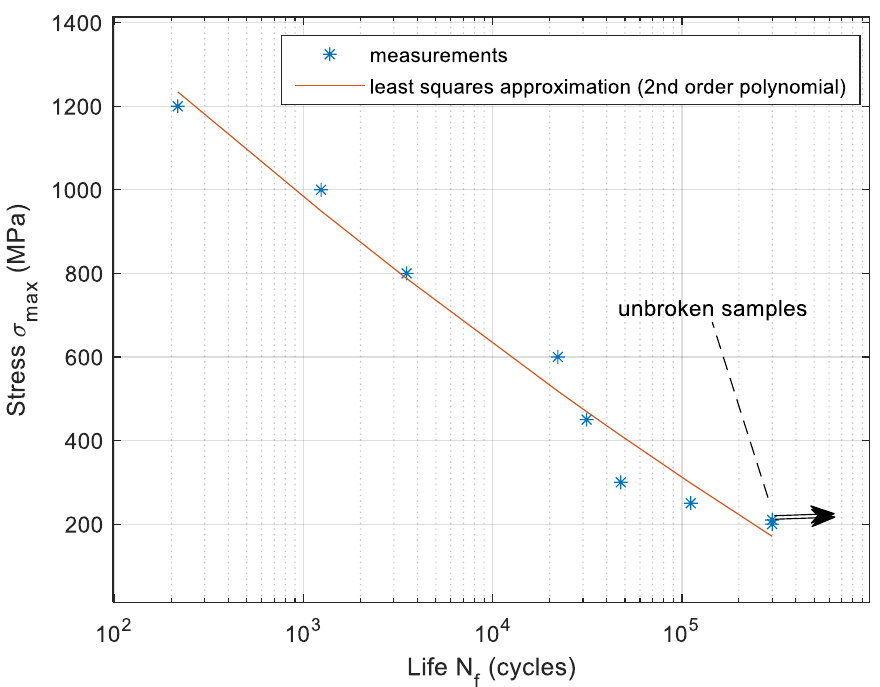
Figure 3. The S–N curve for additively manufactured maraging steel, R = 0.05. Comparison of the obtained results with the literature data revealed that the samples made with the additive technologies were damaged at a much lower load. Based on the test results at 300,000 cycles, it can be concluded that the AM samples were approximately 16% less resistant to fatigue compared with the weakest maraging